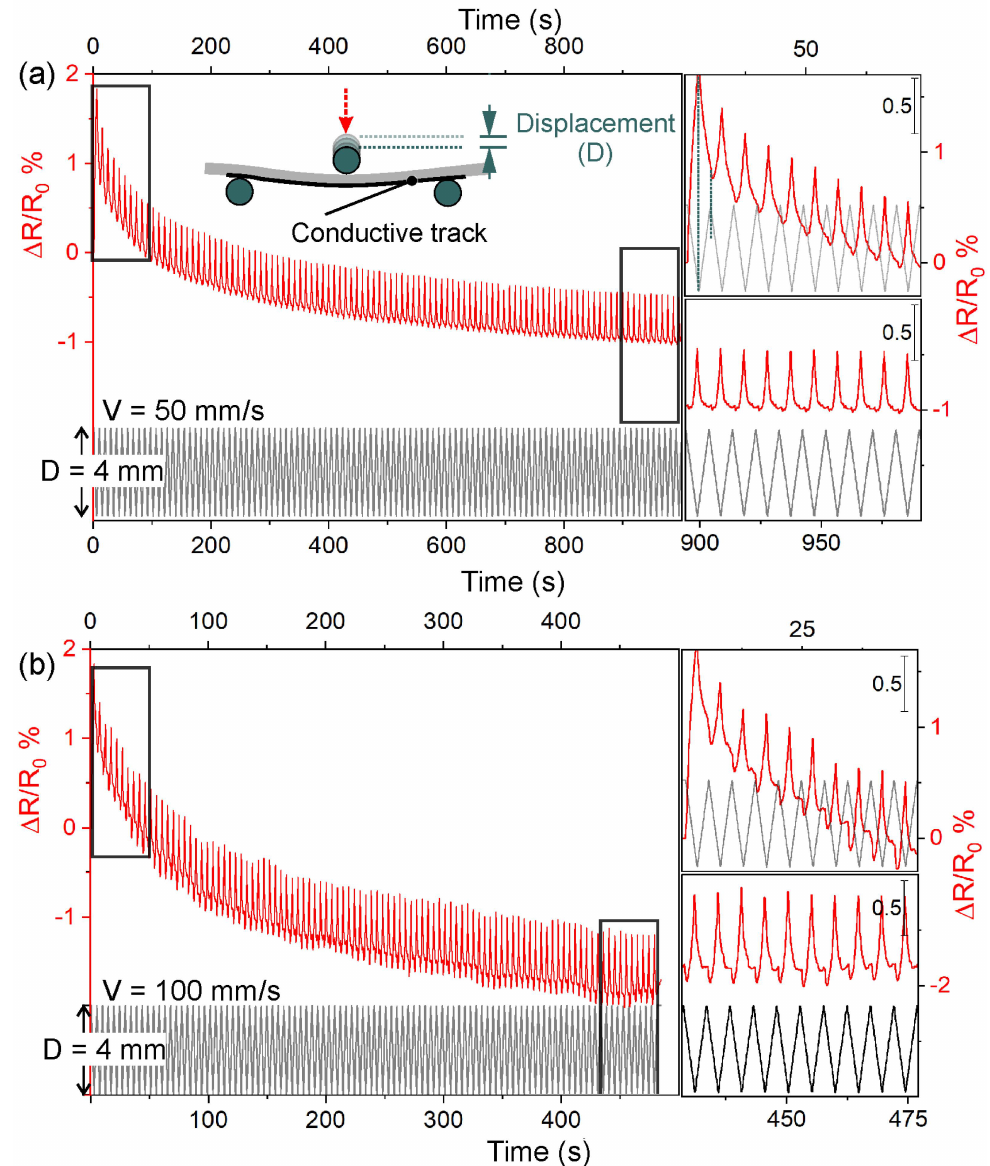
Figure 8. Piezoresistive response of the 60 mm laser-irradiated conductive tracks in the 2 wt.% GO-loaded PU composites measured by the 3-point bending method for 4 mm of displacement for different cycling speeds. Variation of ∆ R/R 0 (red line) for 100 loading/unloading cycles (black line) using ( a ) 50 mm/s and ( b ) 100 mm/s. ∆ R/R 0 variation in the first and last 10 loading/unloading cycles of ( a , b ) is shown in the top and bottom insets,